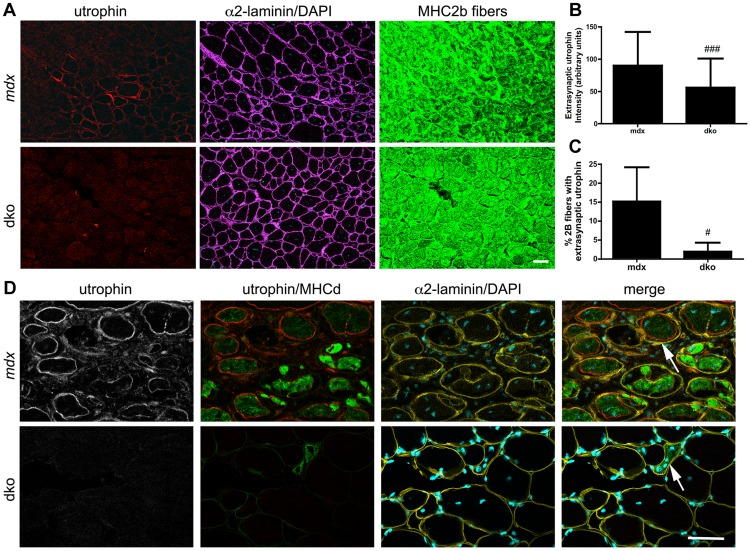
Utrophin expression was reduced on the extrasynaptic sarcolemma of dko fast 2b fibers.
A) Utrophin expression in transverse sections of the near pure population of fast 2b fibers in the most superficial region of the gastrocnemius muscles. Shown are single sections from mdx4cv or dko gastrocnemius fast 2b fibers labeled with utrophin in red, α2-laminin in magenta, DAPI in cyan and fast 2b fibers in green. B) Quantitation of maximal extrasynaptic utrophin fluorescence intensity in fast 2b fibers and C) the proportion of fast 2b fibers expressing extrasynaptic utrophin in the mdx4cv and dko. All bars represent the mean +/− S.D. from n = 4 mice. #
P<0.05 and ###
P<0.001 compared with mdx4cv fibers. D) Regenerating fibers expressed utrophin in the mdx4cv fibers, but not in the dko. Shown are single sections from mdx4cv or dko superficial gastrocnemius muscles labeled with utrophin in red, developmental myosin heavy chain in green, α2-laminin in yellow and DAPI in cyan. Note that utrophin is on the expanding sarcolemma in mdx4cv muscles, but not in the dko (arrows). Scale bars  = 50 µm.